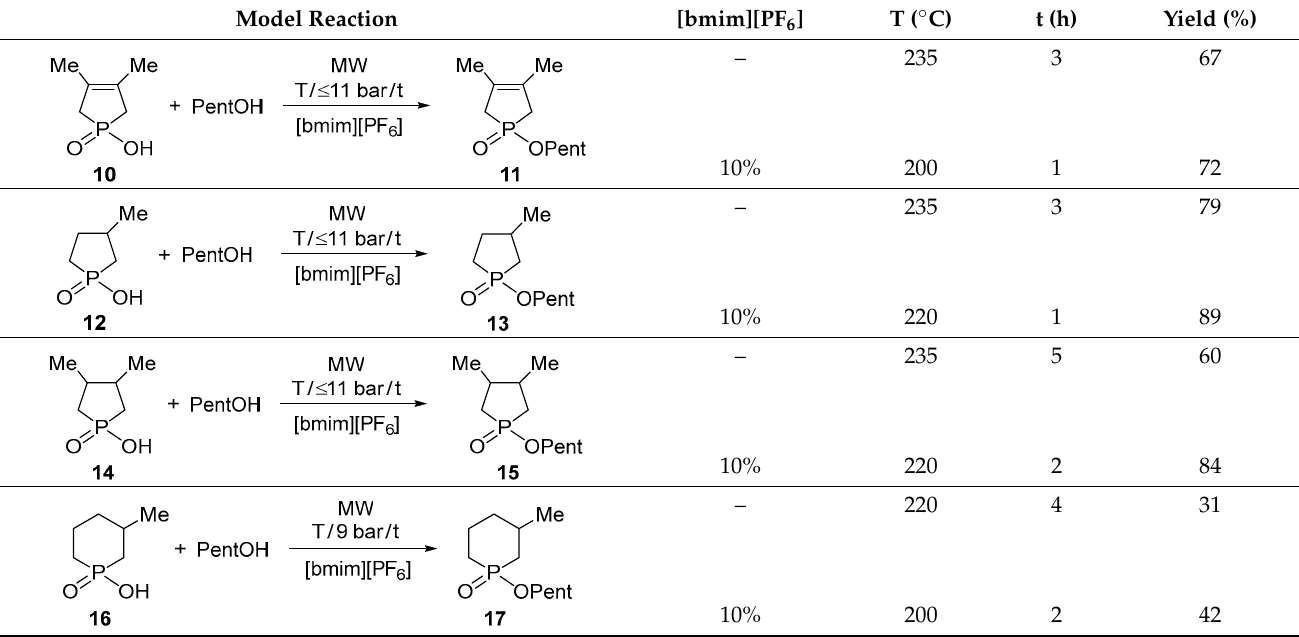
Table 2. Extension of the MW-assisted IL-catalyzed direct esterification to other cyclic phosphinic acids.